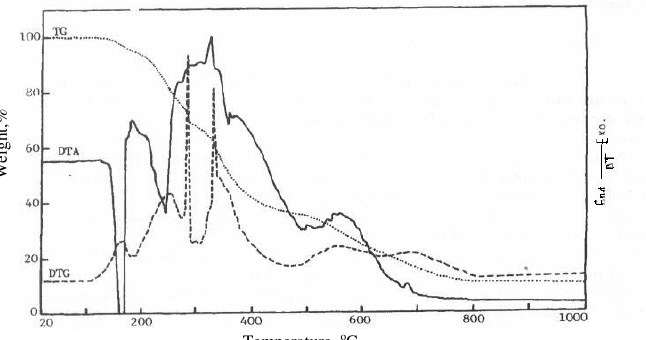
Figure 8. DTA, TG and DTG curves of [Fe(NTEH